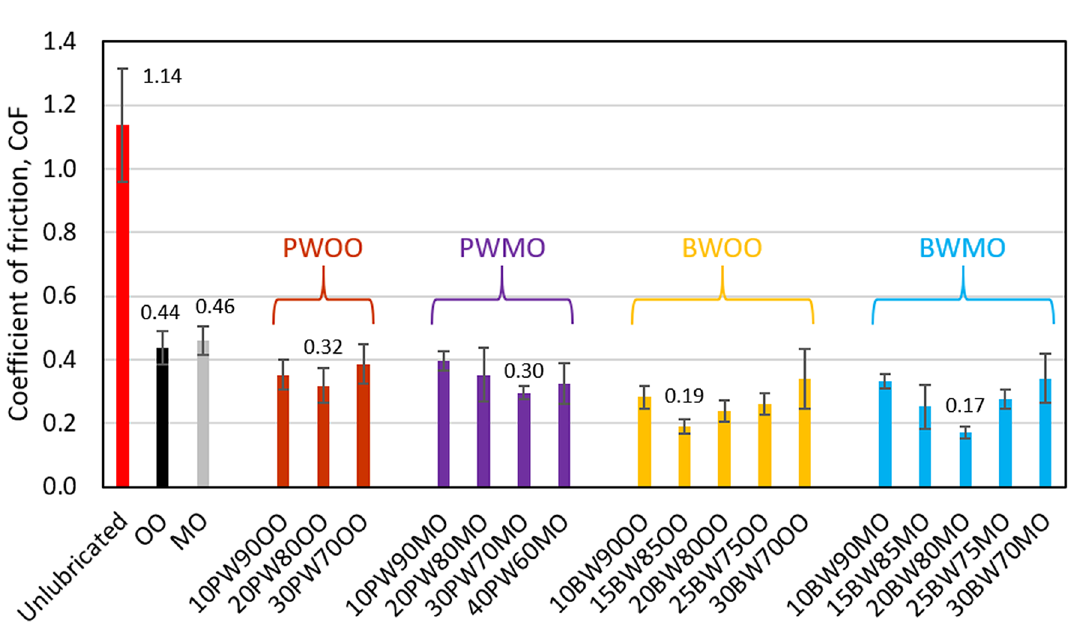
Figure 3. Overview of instantaneous static CoF of various lubricants with unlubricated skin as a baseline for comparison. BW stands for beeswax, PW is paraffin wax, OO is olive oil, and MO is mineral oil. As a naming convention for the various mixtures, the weight percent of each component is listed in front of the specific component, e.g., 20BW80MO represents a 20 wt% beeswax and 80 wt% mineral oil